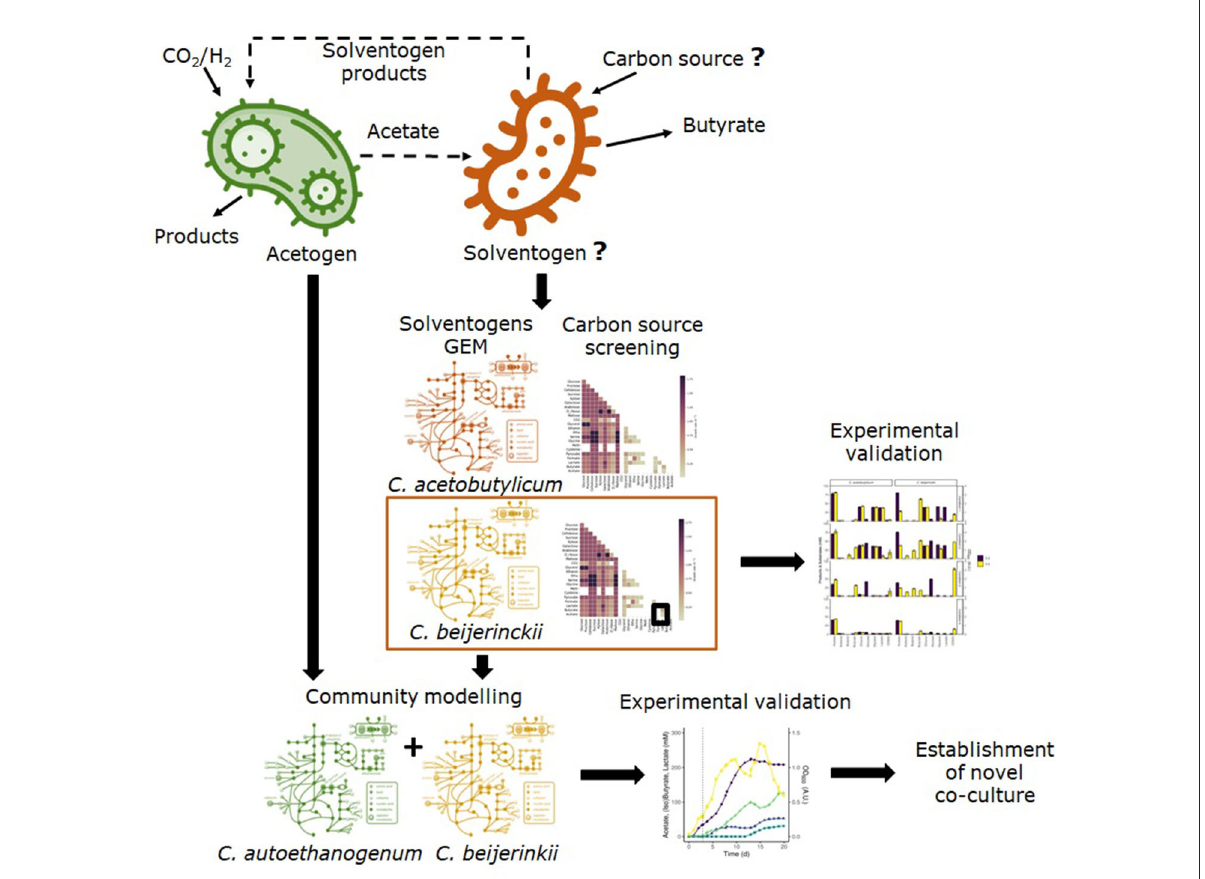
FIGURE1 Overview of the followed methodology to establish a co-culture of an acetogen and a solventogen to produce butyrate from CO 2 /H 2 . We used genome-scale metabolic models of two solventogens to assess growth on several carbon sources and to find the alternative carbon source that sustained growth on the solventogen with acetate. The predicted carbon sources were experimentally validated and growth was confirmed in one of the solventogens. After that, we assessed the feasibility of the co-culture of the acetogen C. autoethanogenum and the